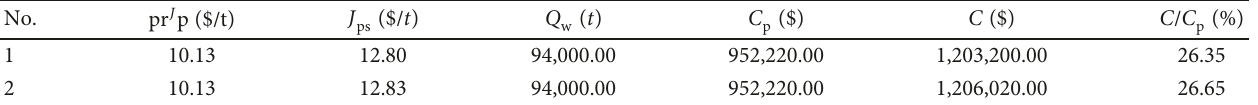
Table 3: Unit cost, quantity, and planned and real total costs of the system.